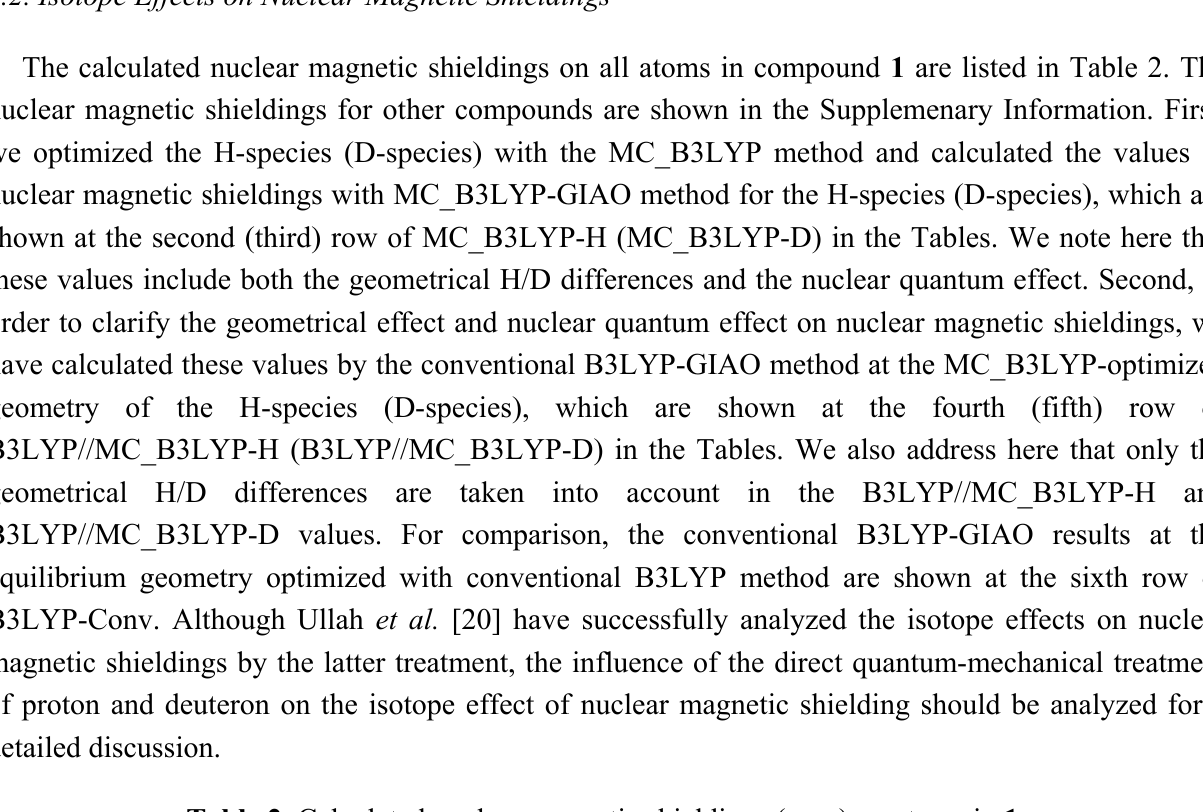
Table 2. Calculated nuclear magnetic shieldings (ppm) on atoms in 1